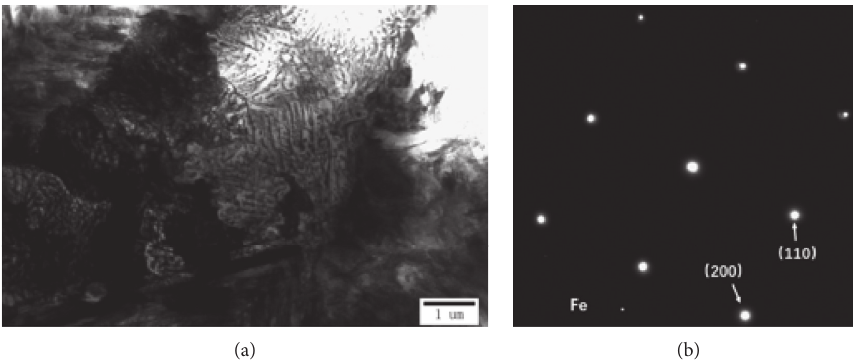
Figure 7: TEM micrograph of the WAAM-printed sample (a) and the corresponding SAED pattern (b).